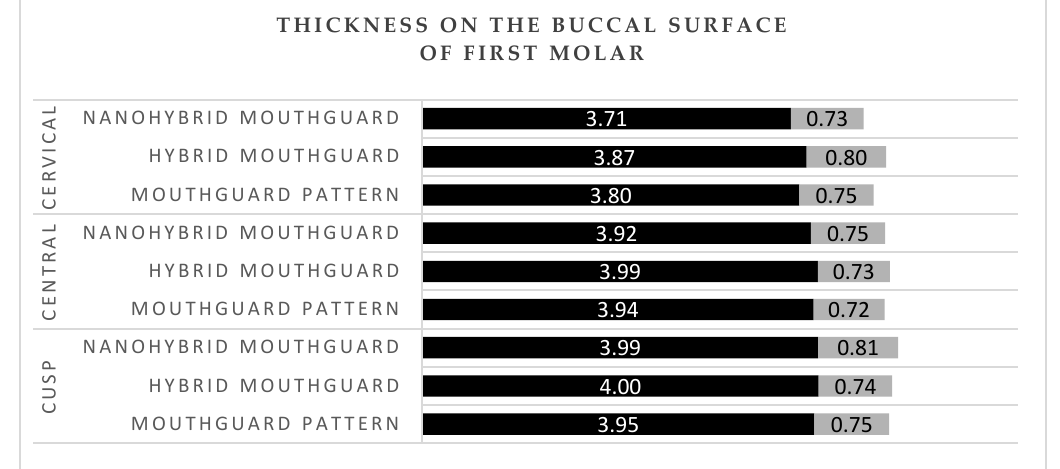
Figure 5. Thickness at the buccal surface of first molar. Black—mean value; grey—standard deviation (SD).